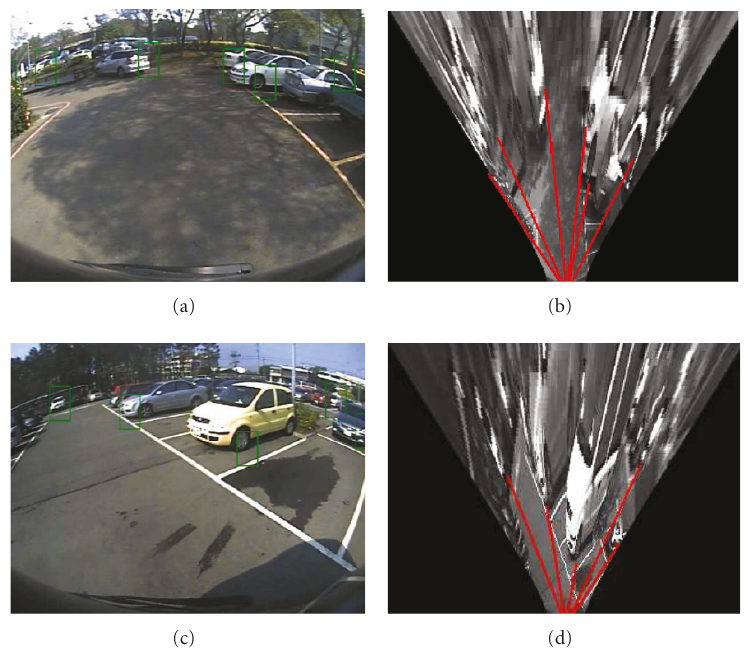
Figure 26: Results of obstacle warning in the rear